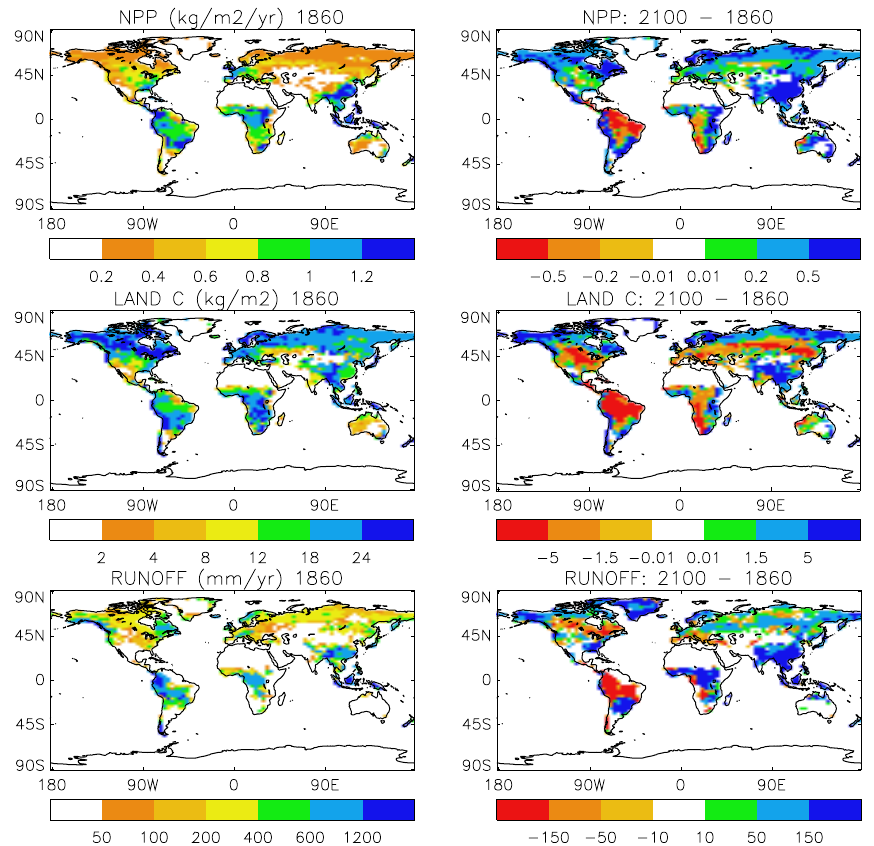
Fig. 5. Predictions of Net Primary Productivity, terrestrial carbon content (soil and vegetation) and runoff for year 1860, the start of the IMOGEN transient simulation (left hand panels). These values are considered representative of pre-industrial state. The right hand panels show the changes in each of these quantities during the period 1860 to 2100. These simulations all correspond to the SRES A2 (CO 2 emissions only) scenario, and with the EBM2 configuration of